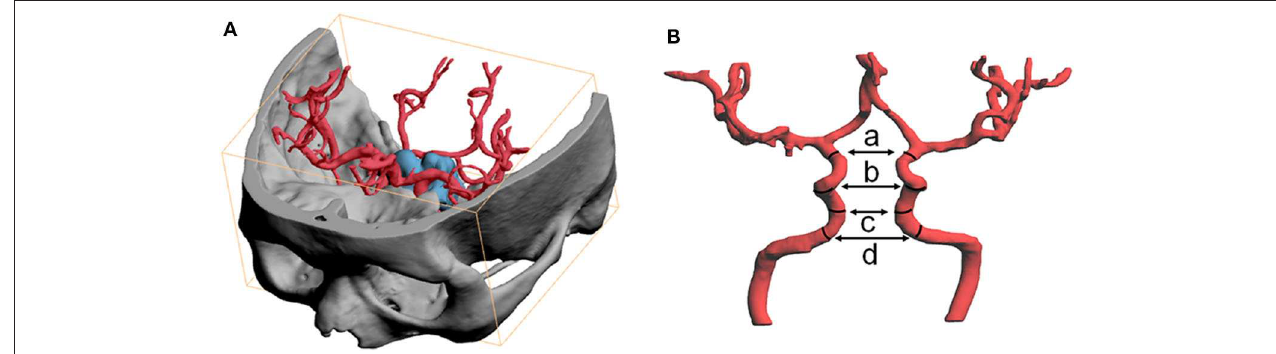
FIGURE 1 | Three-dimensional image software was used to reconstruct the ICAs and to measure intercarotid distance. (A) The image data were exported as DICOM format file and further imported to three-dimensional image process software to reconstruct skull, pituitary adenoma and the ICAs. Fused image of skull and ICA was used to determine segments of ICA. (B) Measurement of intercarotid distance, parameters including (a) the distance between the inner walls of the bilateral carotids at the level of distal dural ring (ophthalmic segment); (b) the istance between ICAs at the level of the most concave point of the C4-C5 bend (siphon carotid ectasias segment); (c) the distance between ICAs at the level of posterior ascending portion of C4 segment (cavernous segment); (d) the maximum distance between ICAs at the level of C3 segment (lacerum segment).